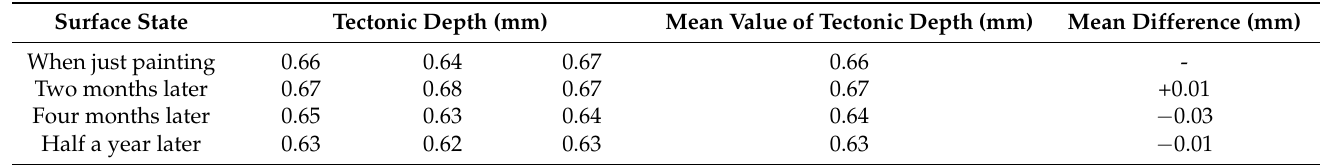
Table 12. Comparison of texture